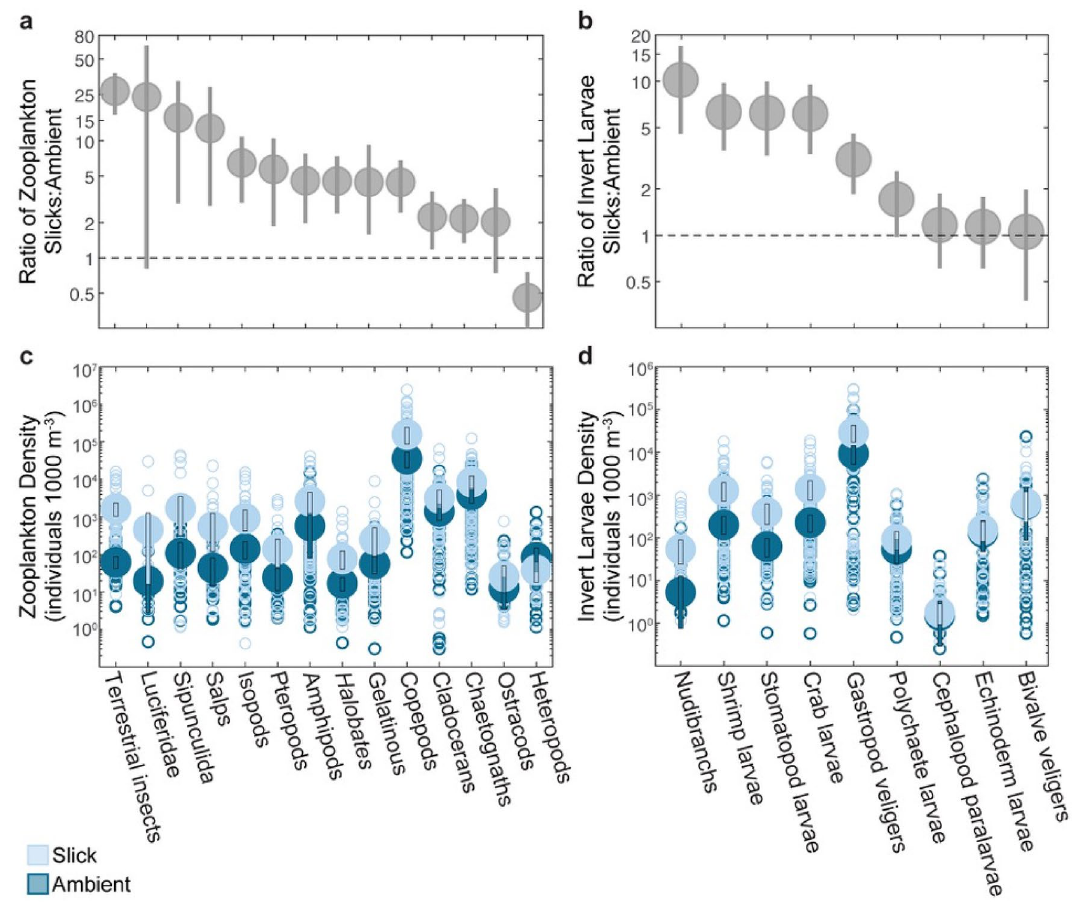
Figure 3. Densities and response ratios of zooplankton groups in surface slicks compared to ambient waters. ( a , b ) Ratio of mean density in slicks to mean density in ambient water ± 95% bootstrap intervals for ( a ) zooplankton (i.e., holoplankton) and ( b ) invertebrate larvae (i.e., meroplankton). The dashed line at Y = 1 indicates equal densities in both habitats. ( c , d ) Mean (± 95% bootstrap intervals) densities of ( c ) zooplankton and ( d ) invertebrate larvae (individuals 1000 m −3 ). Open circles indicate individual neuston tow samples in slicks (light blue) and ambient waters (dark blue) as follows: zooplankton, invertebrate larvae ( n = 80 slick, n = 54